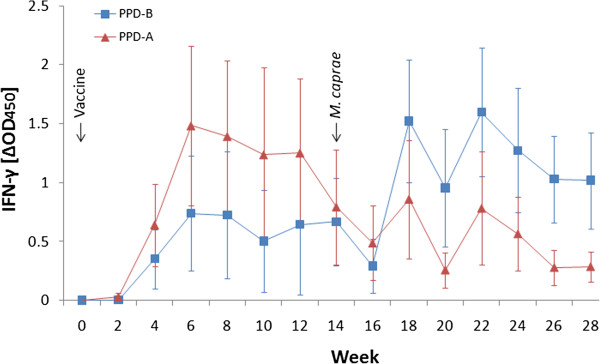
Kinetics of IFN-γ released after stimulation of whole blood with tuberculins in the vaccinated group. Avian tuberculin (PPD-A, ▲), bovine tuberculin (PPD-B, ■). Results are expressed as mean ΔOD450 (mean of OD450 of antigen-stimulated values with unstimulated values subtracted) ± 95% confidence interval.